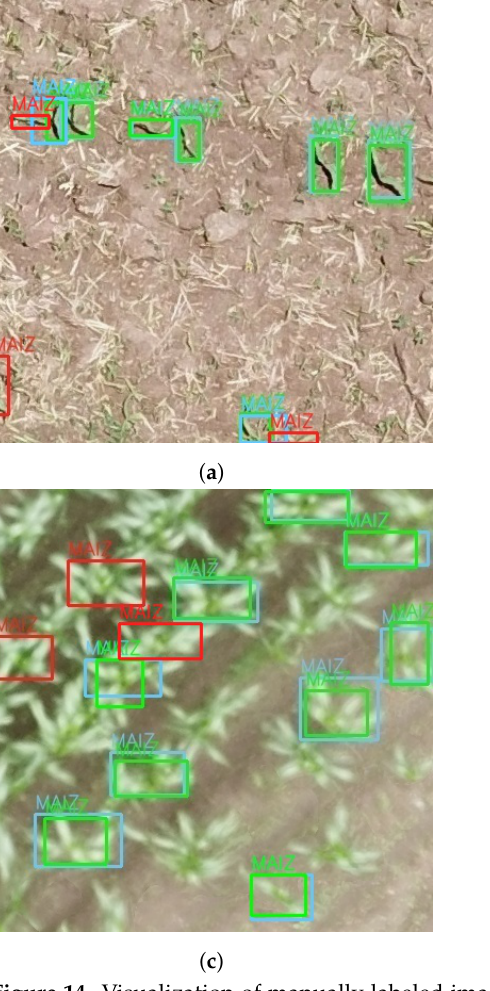
Figure 14. Visualization of manually labeled images (blue box), TP (green box) and FP (red box). Detection of vegetative stage ( a ) V 3 with YOLOv4, ( b ) V 7 1.00 with YOLOv5-s, ( c ) V 8 1.00 with YOLOv5- s and ( d ) V 6 1.00 with